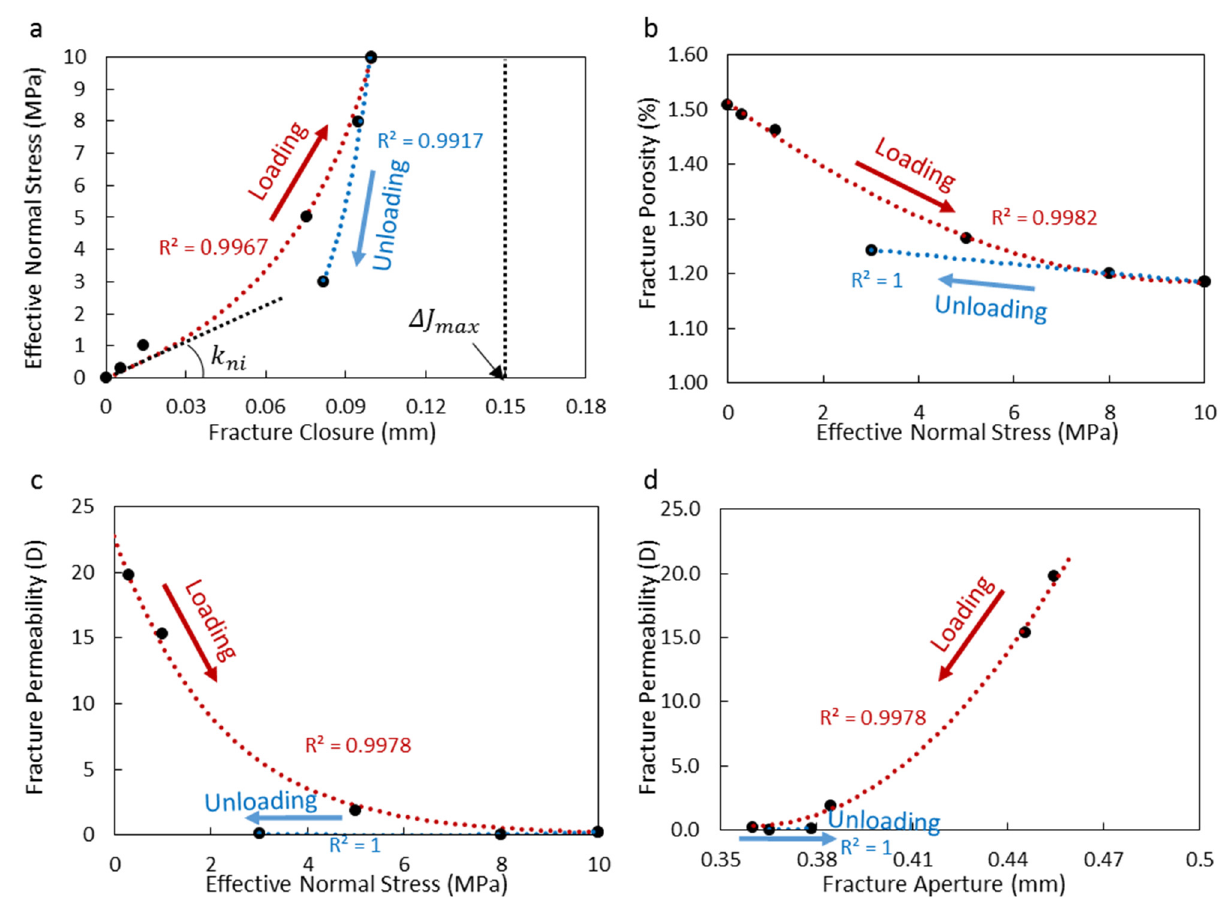
Figure 5. Core-scale experimental results showing the stress dependency of structural and single- phase flow properties of the fractured rock during loading and unloading cycles: ( a ) effective normal stress versus fracture closure plot, ( b ) stress-dependent fracture porosity, ( c ) stress-dependent fracture absolute permeability, and ( d ) fracture permeability and aperture relation.